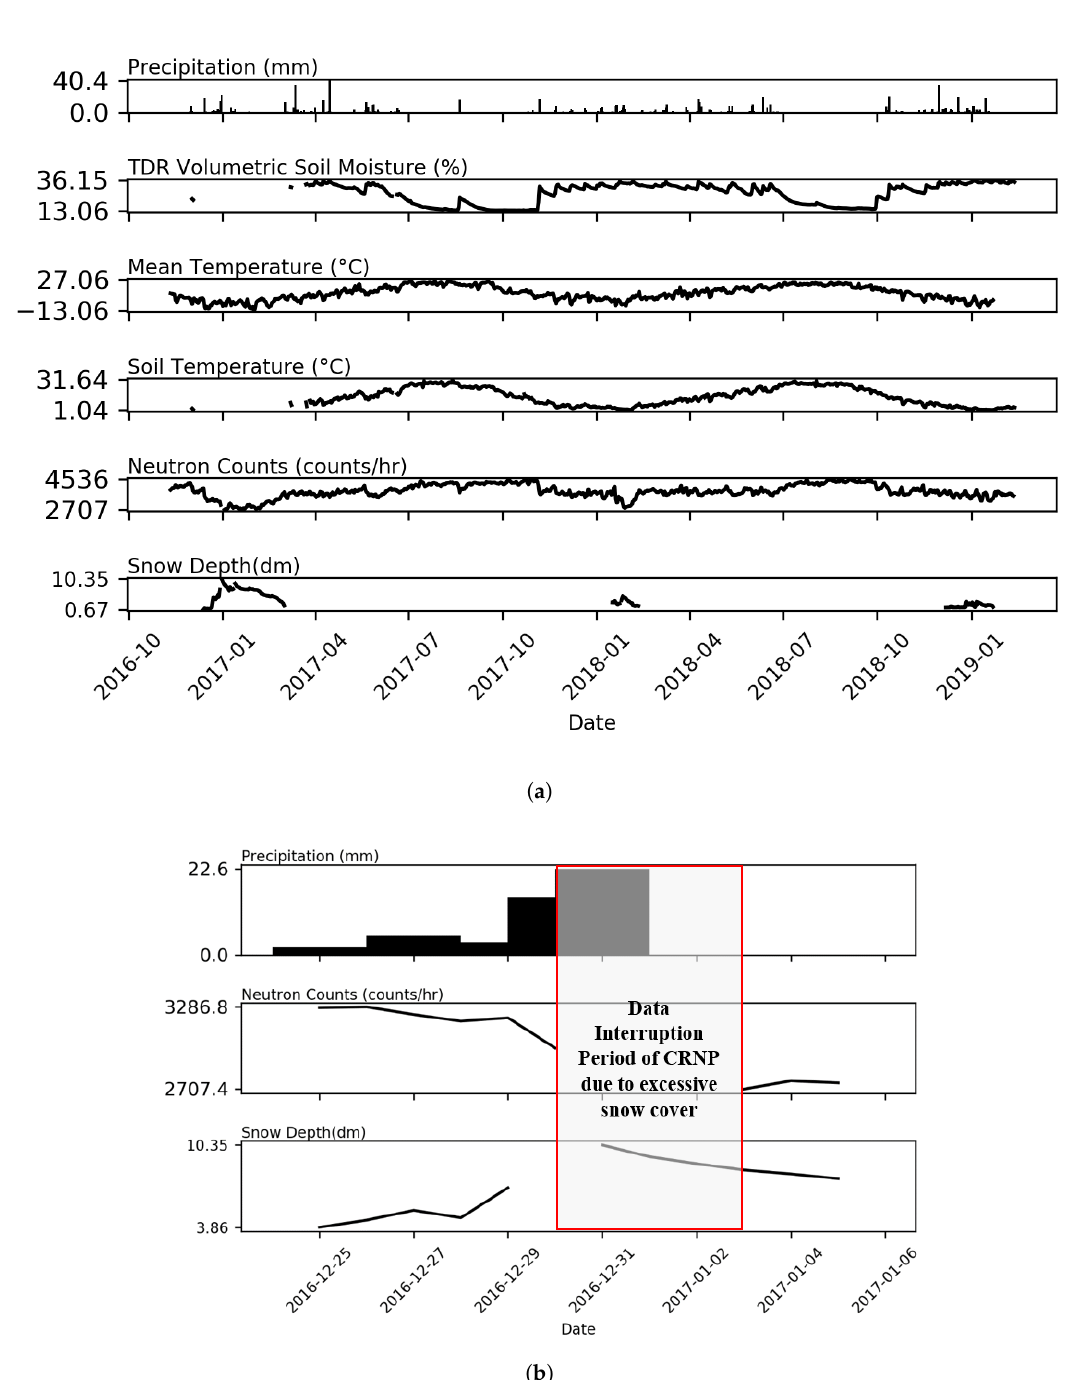
Figure 3. ( a ) Precipitation, mean temperature, soil moisture measurements (TDR), soil temperature and snow height data observed at the site. ( b ) Data interruption period of Çakıt